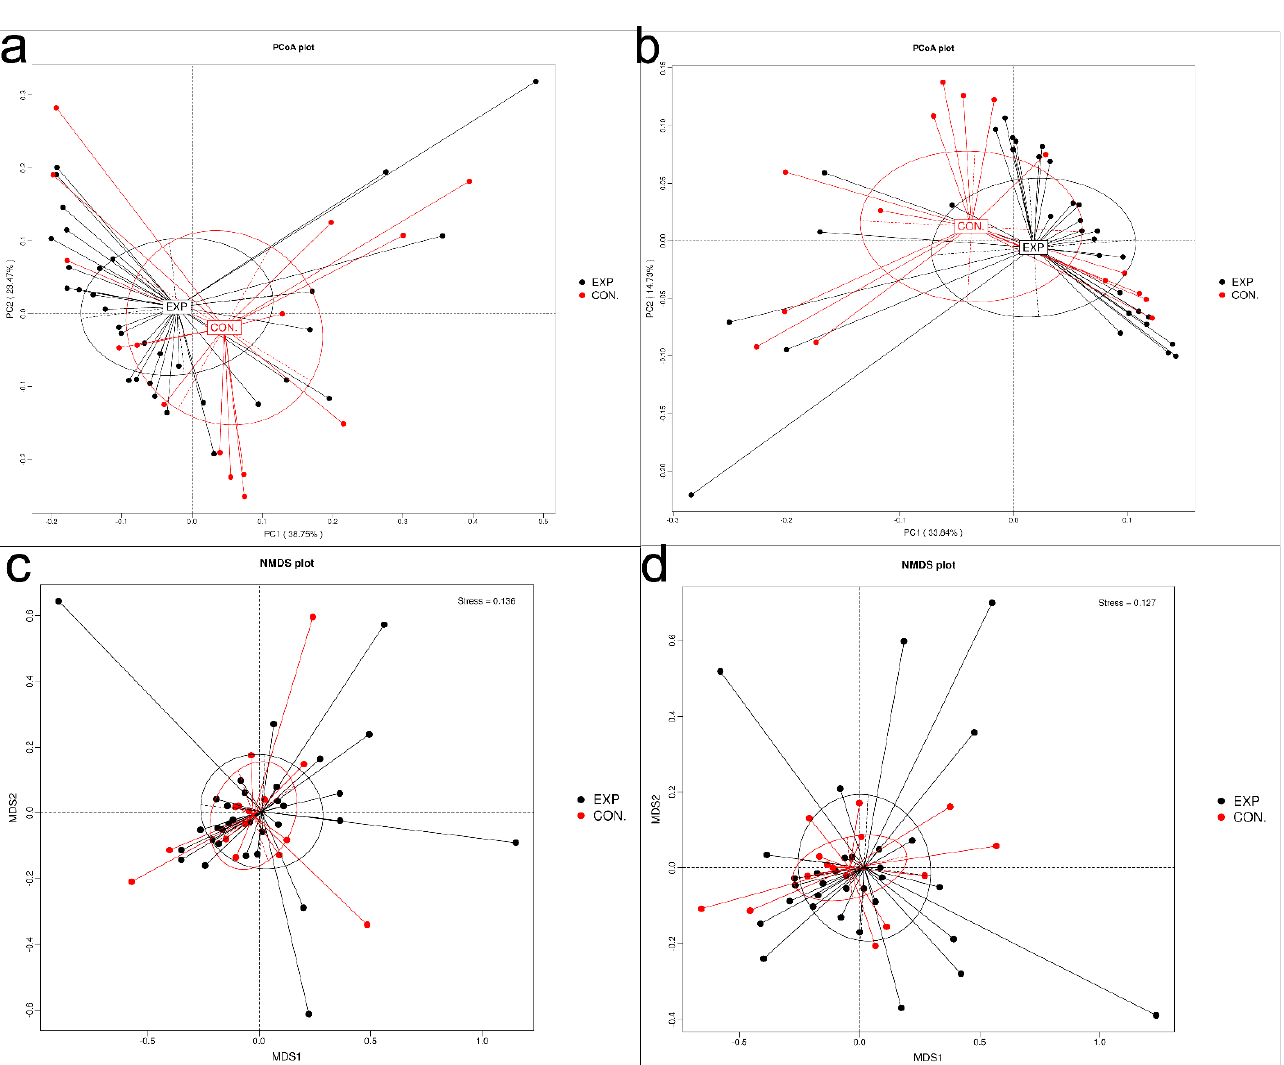
Figure 3. Dimension-reducing analysis based on species abundance (BLCA patients, EXP group; healthy individuals, CON group). Each point in the graph indicates a sample, and samples from the same group were represented using the same color. The distance between points indicated the degree of difference. ( a ) At the genus level, PCoA is shown. ( b ) At the species level, PCoA is shown. ( c ) At the genus level, NMDS is shown. Stress point = 0.136. ( d ) At the species level, NMDS is shown. Stress point = 0.127.